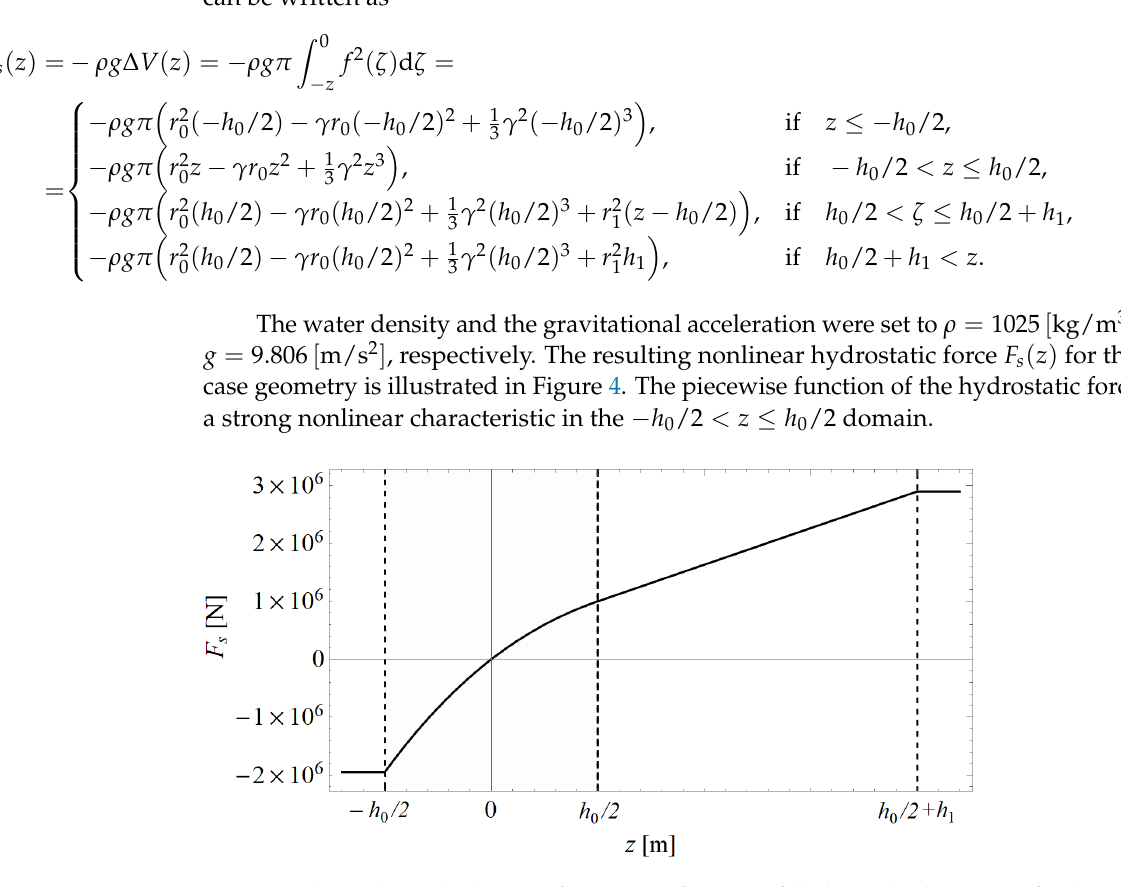
Figure 4. The nonlinear hydrostatic force F s as a function of the buoy displacement z for the test case